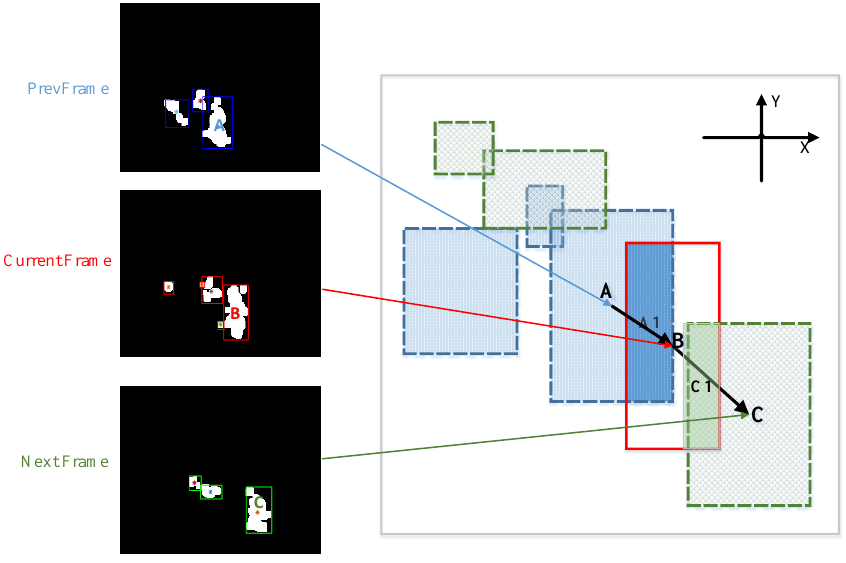
Figure 5. Overlapping ratio